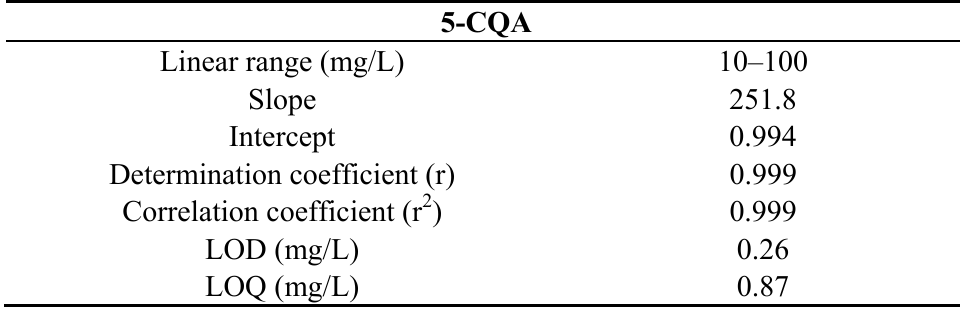
Table 1. Statistical parameters of 5-CQA calibration curve with LOD and LOQ.